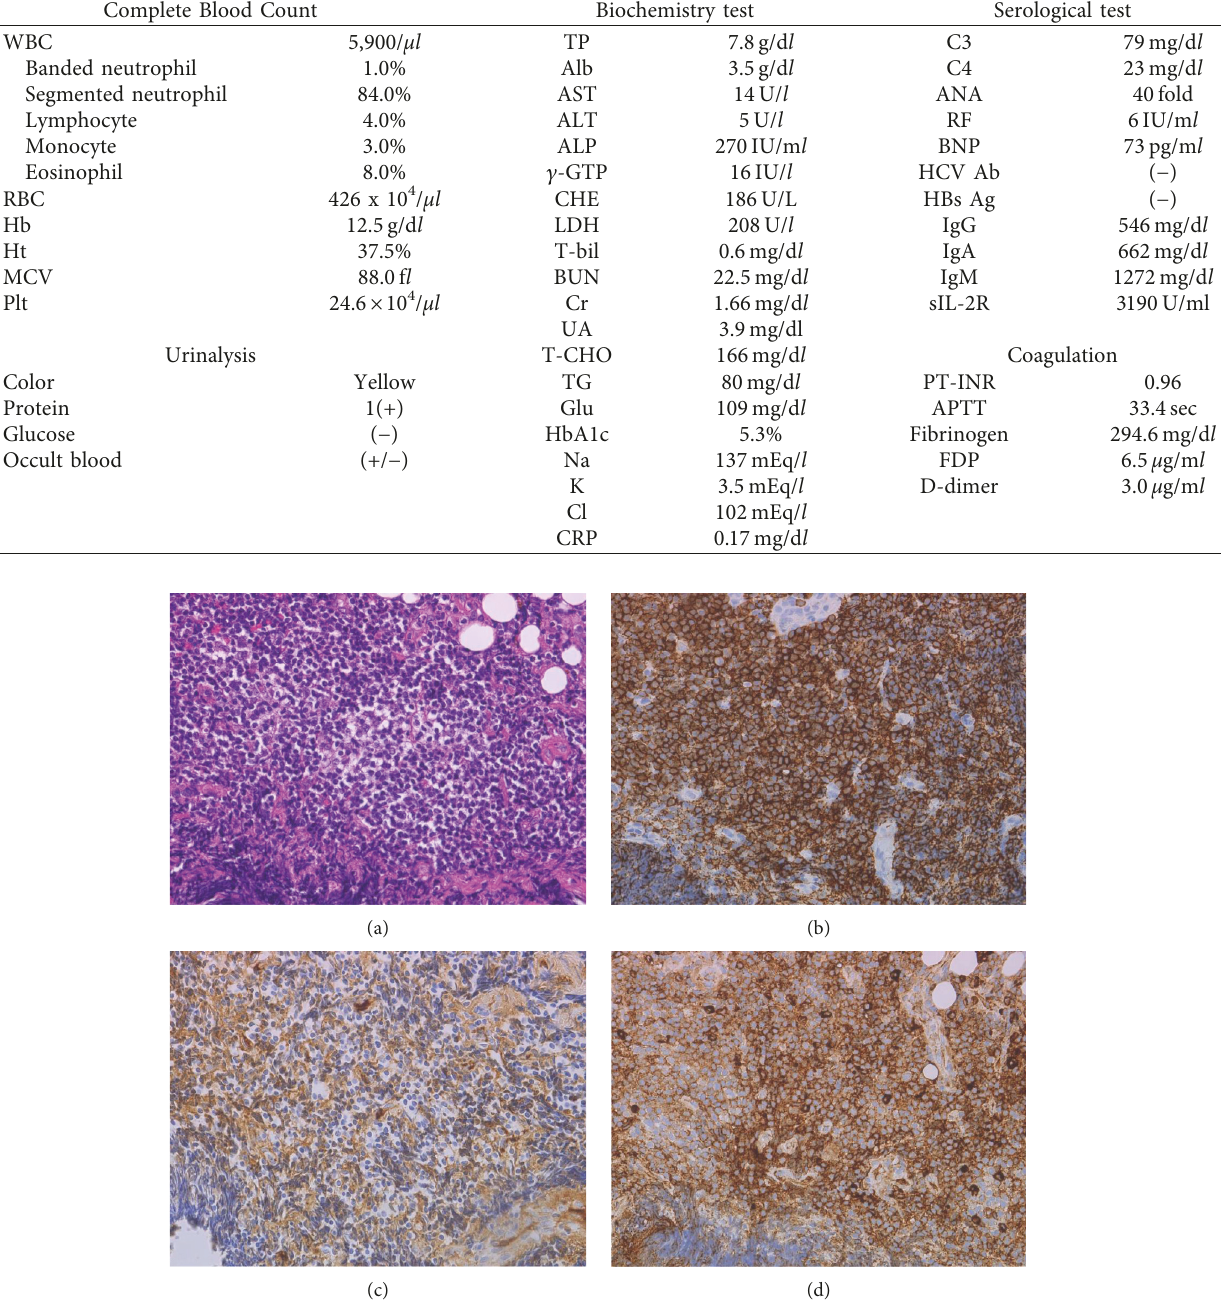
Figure 3: Pleural immunohistochemical staining. (a) Hematoxylin-eosin staining ( × 40). (b) CD20 ( × 40). (c) κ chain ( × 40). (d) λ chain ( × 40).